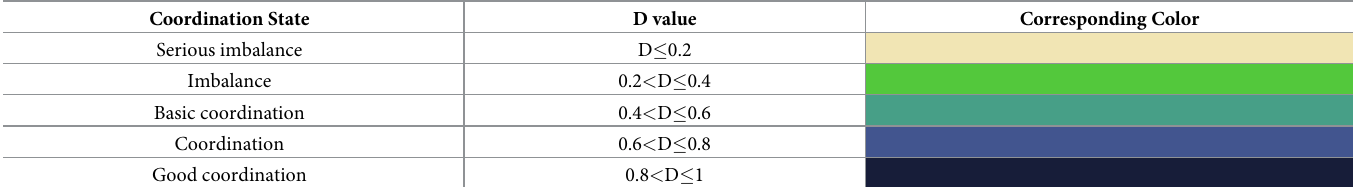
Table 2. Classification standard and types of